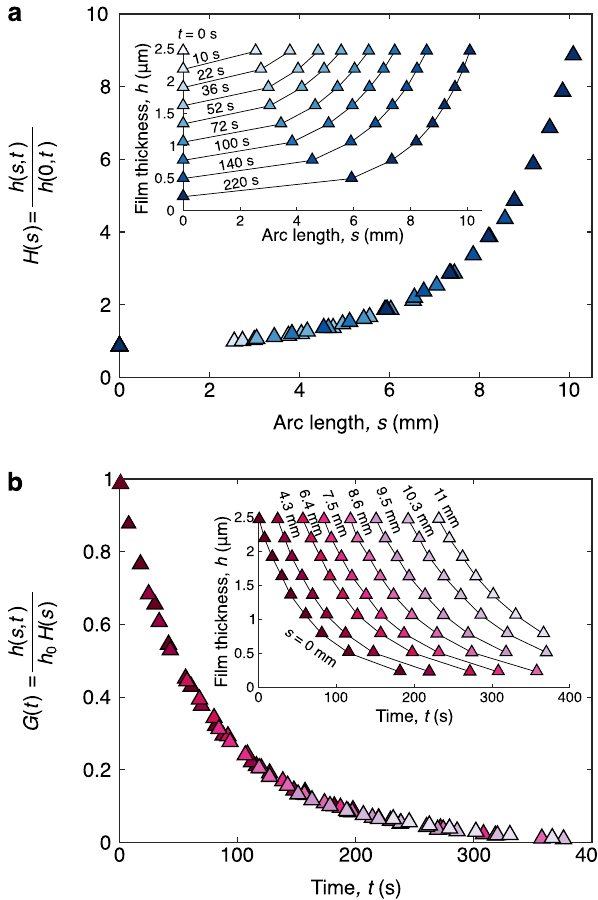
Fig. 2 | Spatial and temporal thickness measurements. a Inner plot: The fi lm thickness increases monotonically with the arc length s with the marker shading denotingdifferent fi xedtimes t .Outerplot:Thesedatapointscollapseontoasingle universalcurve H ( s ). b Inner plot: The fi lm thickness decreasesmonotonically with time t with the marker shading denoting different fi xed locations s . Outer plot: These data points collapse onto a single universal curve G ( t ). Here h 0 ≡ h (0,0) ≈ 2.50 μ m.Note that the lines are a guide to the eye and that error bars are excluded, as they would be smaller than the symbol